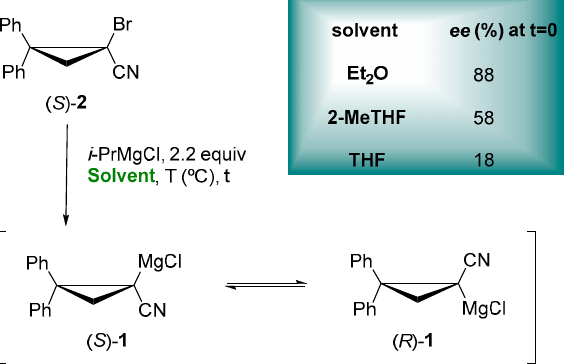
Figure 1. Enantioenriched α -cyanocyclopropyl Grignard reagents.